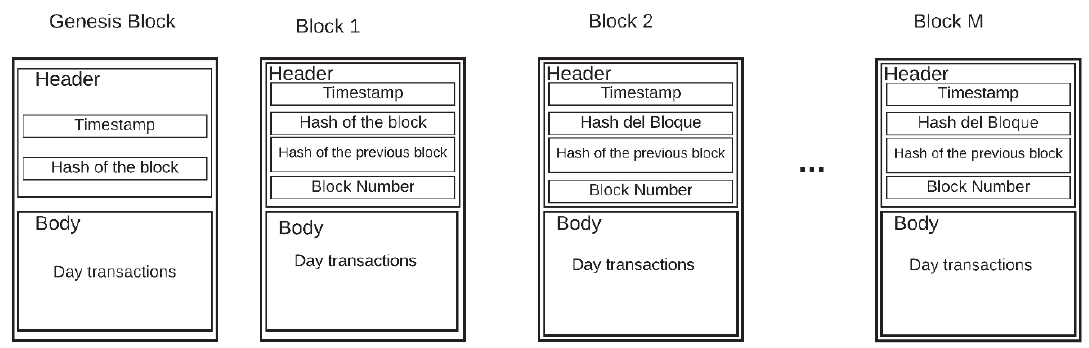
Figure 9. Composition diagram of blockchain system blocks.